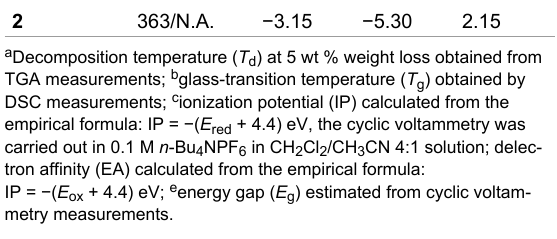
of 1 and 2 are 0.33 and 0.27 eV, which are small enough to achieve TADF